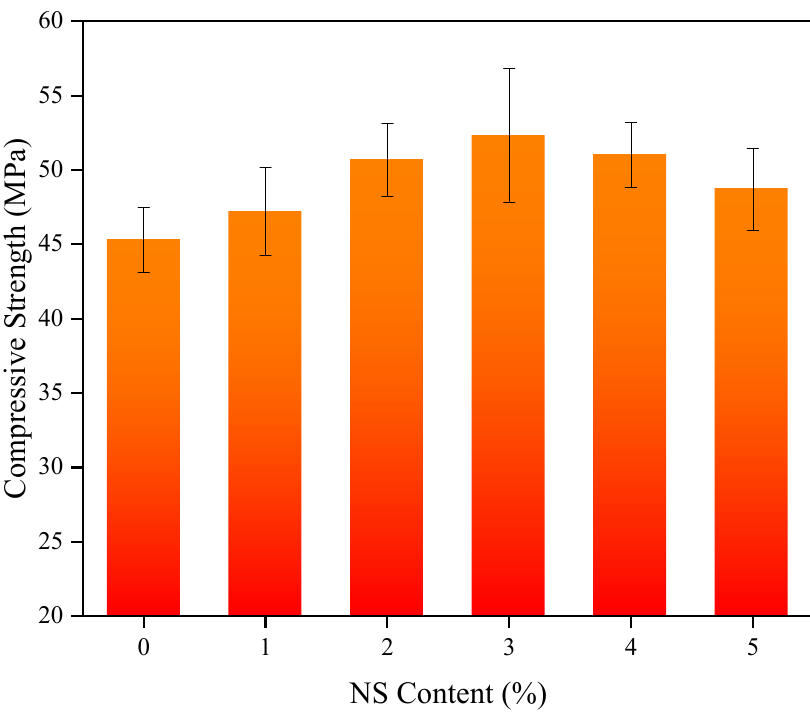
Figure 5. Compressive strength of concrete with NS.